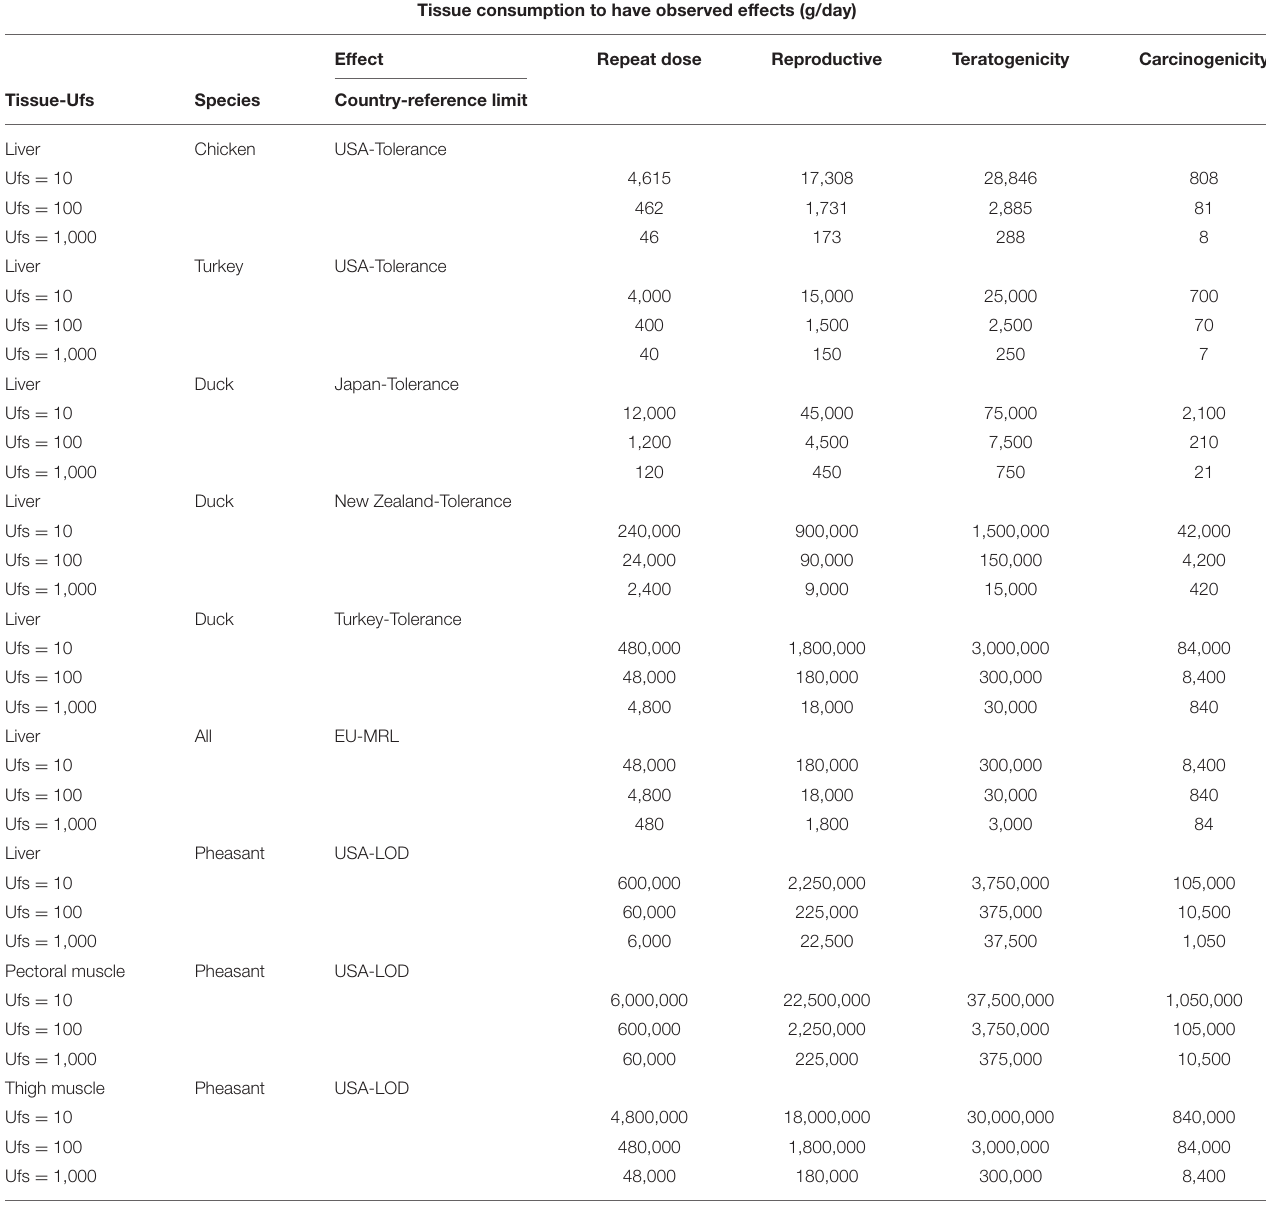
TABLE 4 | Grams/day of previously treated with fenbendazole poultry tissue a person has to consume to have observed adverse effects. Tissue consumption to have observed effects